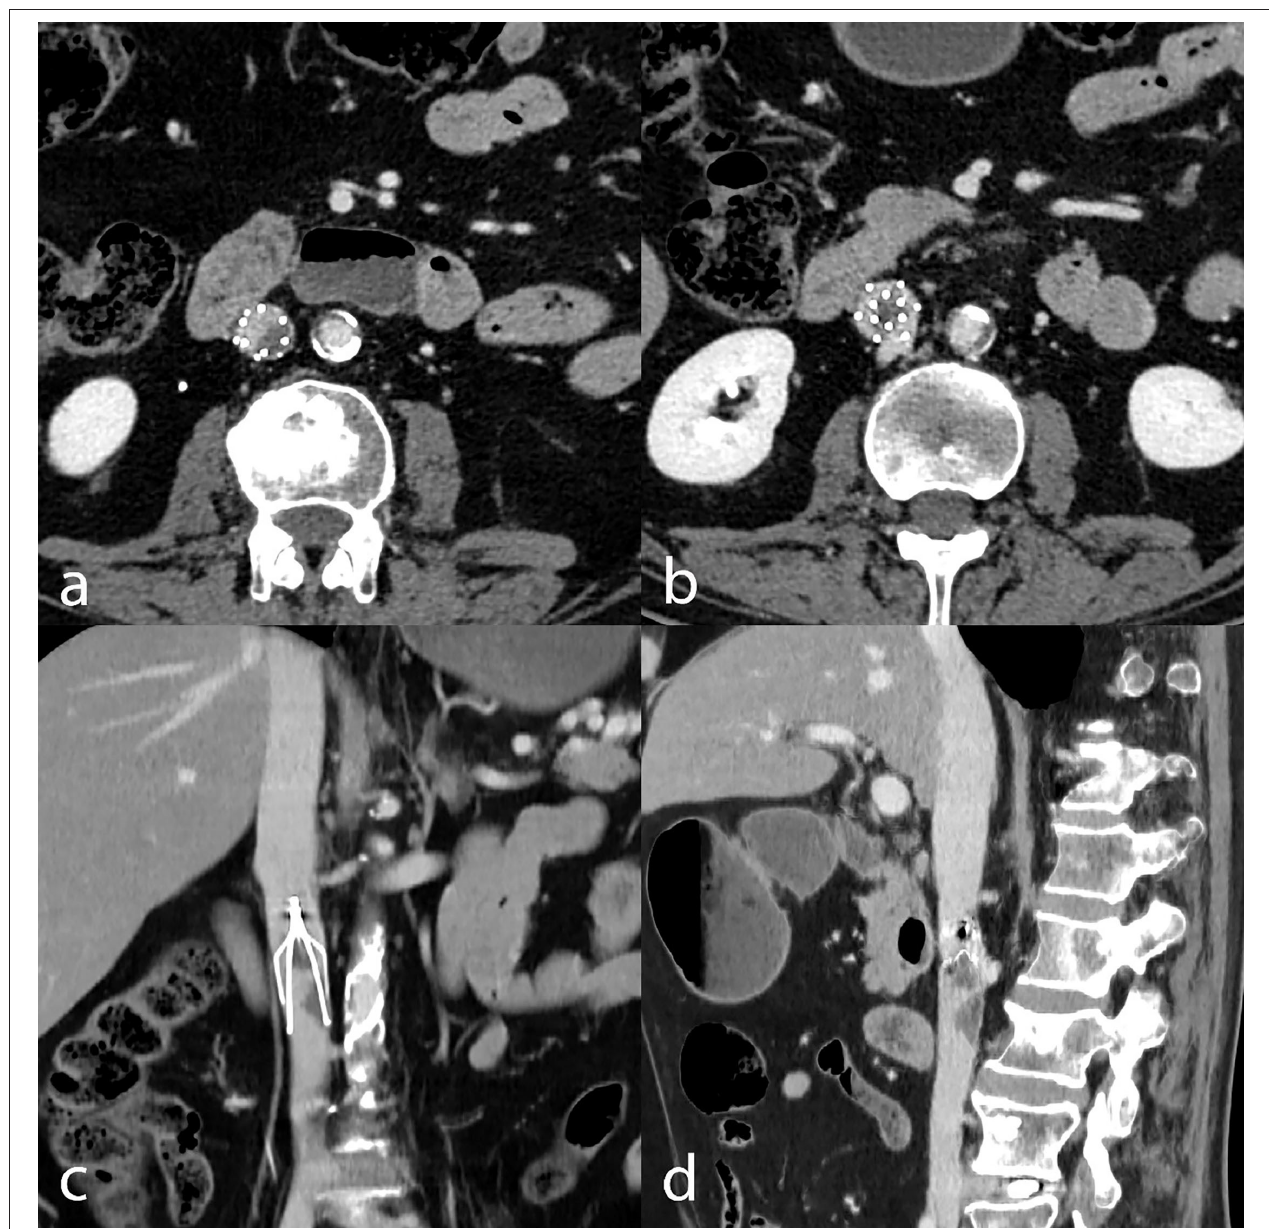
FIGURE 1 | Technical irretrievability due to thrombus inside the filter. CT venography with axial (a,b) , coronally reformatted (c) , and sagittally reformatted minimum-intensity projection (d) images show thrombotic material stuck in the filter, precluding retrieval.